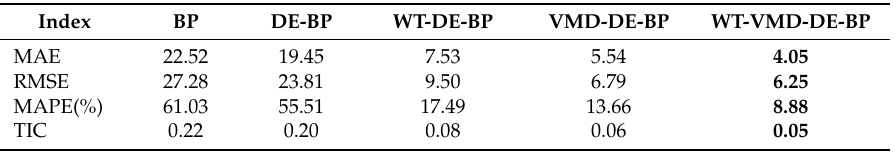
Note: The smallest value of each row is marked in boldface. Table 5. The comparison results of Comparisons I, II and III (Tianjin).